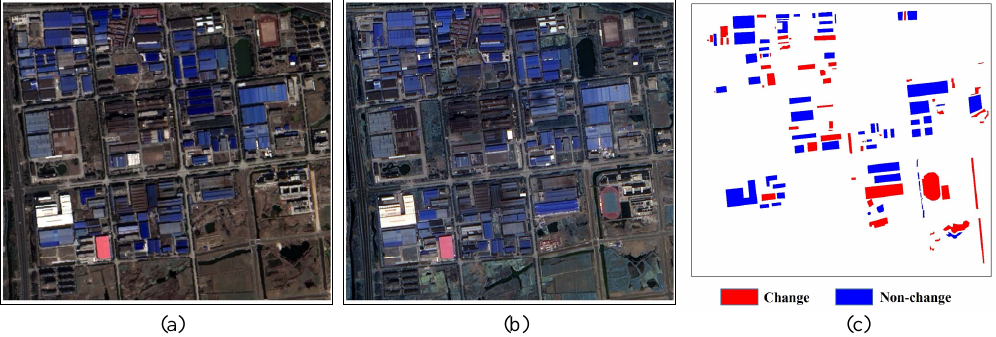
Figure 6. Experimental Area A. ( a ) Image acquired on 10 February 2015; ( b ) image acquired on 27 March 2016; ( c ) standard reference change map.